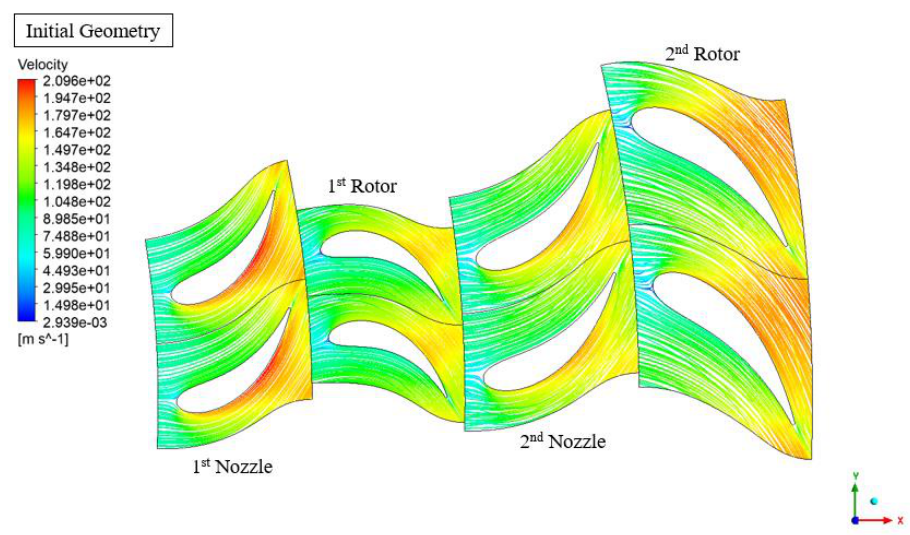
Figure 17. Streamline of the initial geometry.